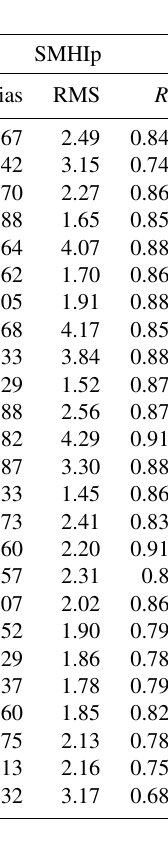
Table 1. RMS (ms − 1 ), bias (ms − 1 ), and correlation coefficients for in situ data from SMHI, the Östergarnsholm wind tower, and satellite